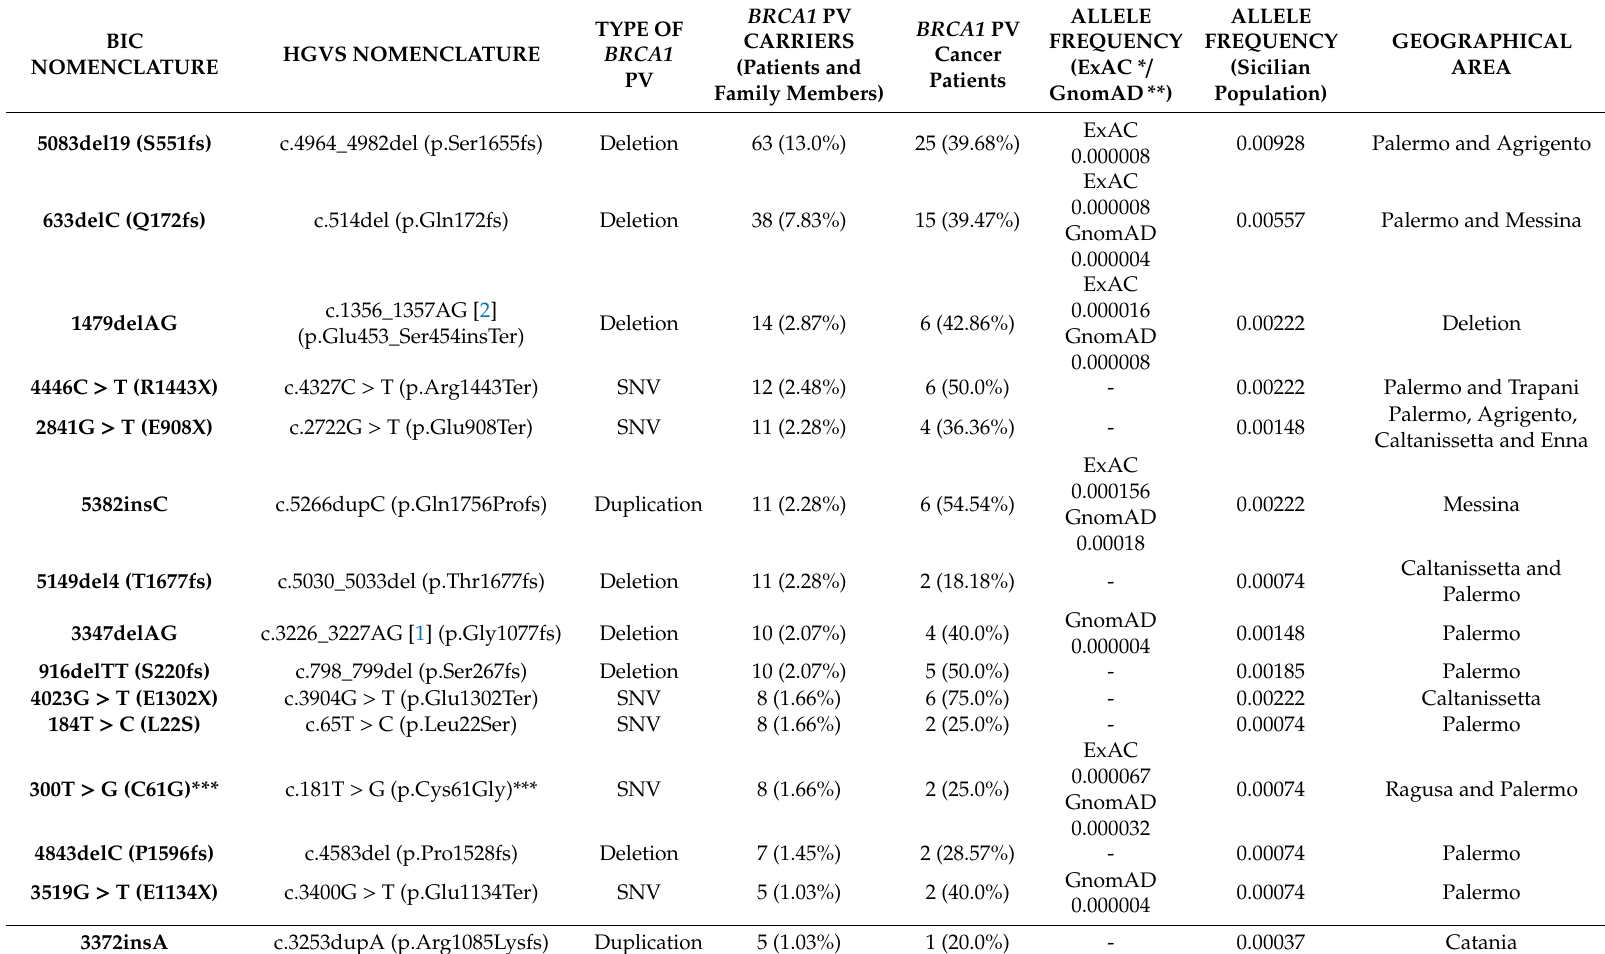
Table 3. Type and frequency of germline BRCA1 PVs (class V) and geographical area of origin of BRCA